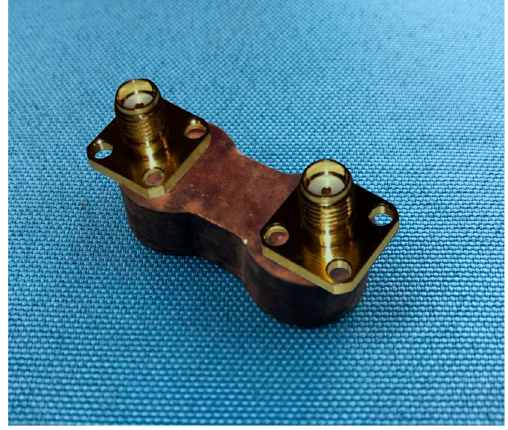
Figure 5. Schematic diagram of mounting position of two SMA connectors on the filter.